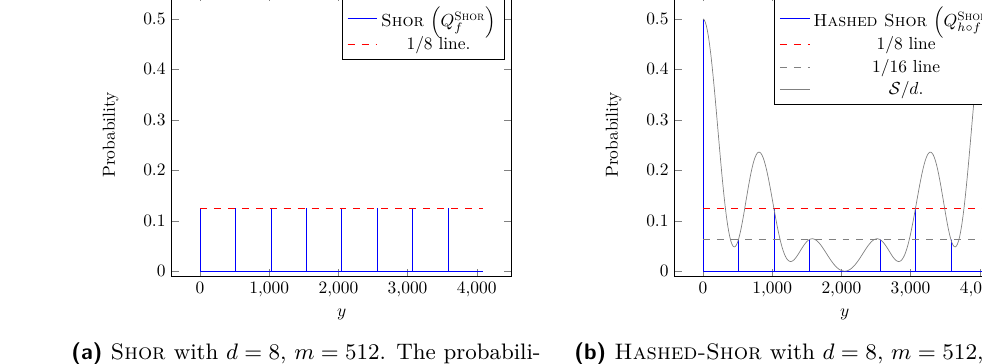
Figure 11: Probability distributions for Shor and